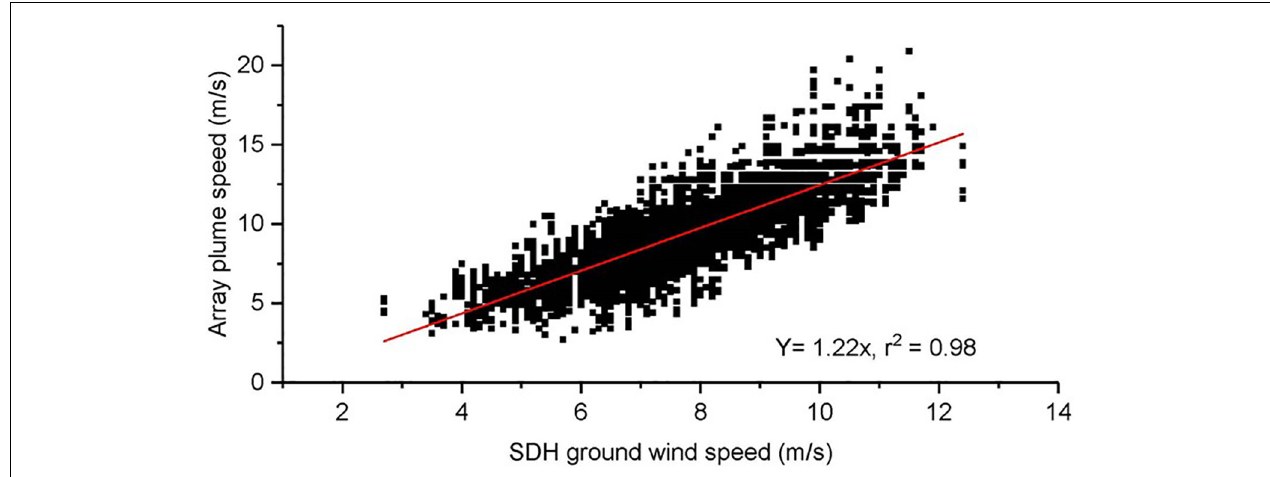
FIGURE 4 | Plume speed calculated from peak correlation using two along-axis FLYSPEC instruments versus 3-m agl wind speed measured with an ultrasonic anemometer (station SDH; Figure 2 ) for June–September 2017. Data is filtered to include only plume speeds used to calculate emission rates (see section “Spectrometer